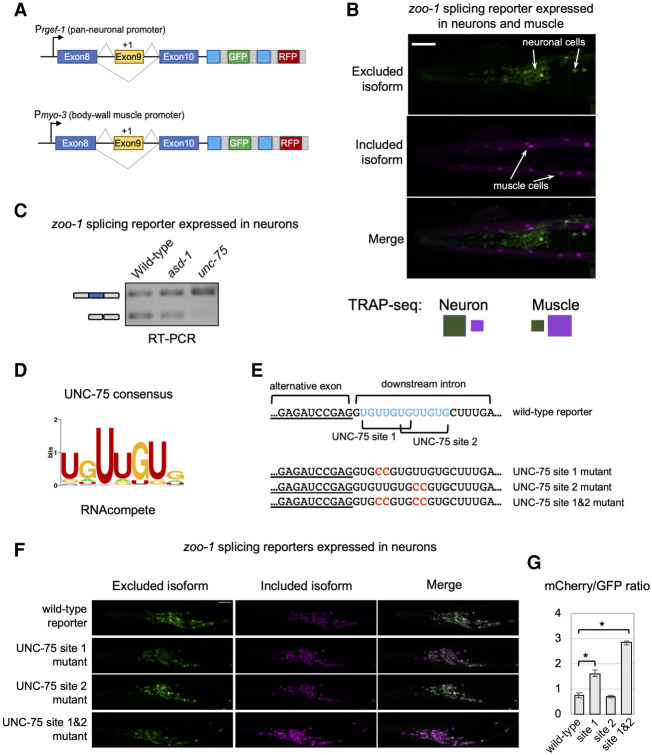
UNC-75/CELF represses inclusion of an exon by binding to cis elements overlapping a 5′ splice site. (A) Schematic of two-color reporters used for experiments. (Prgef-1) Promoter driving pan-neuronal expression; (Pmyo-3) promoter driving body-wall muscle expression. (B) Fluorescence microscopy images of zoo-1 two-color reporter monitoring splicing of exon 9 in both neurons and muscle cells. Neurons display increased exon skipping (green), whereas muscle cells primarily include the alternative exon (purple). Scale bar, 20 μm. (C) RT-PCR assay monitoring zoo-1 two-color splicing reporter expressed only in neurons in wild-type animals (lane 1), asd-1 mutants (lane 2), and unc-75 mutants (lane 3). Primers are designed to amplify both exon 9 included (top band) and excluded (bottom band) isoforms. (D, left) UNC-75 consensus motif derived from RNAcompete data (Ray et al. 2013). (E, top) Schematic of 3′ end of zoo-1 exon 9 (underlined) and flanking downstream intron sequence. Two UNC-75 consensus sequences overlapping the 5′ splice site are highlighted in blue. (Bottom) Reporters with mutated UNC-75 consensus sequences (substitutions in red). (F) Fluorescence microscopy images of wild-type and mutant two-color zoo-1 reporters as described in E. Scale bar, 20 μm. (G) Bar graph displaying mCherry/GFP fluorescence intensity ratios for each zoo-1 splicing reporter. Each bar represents mean ratio from five individual animals. Error bars, ± 1 SD from the mean value. (*) P-value < 0.01, Kruskal–Wallis rank sum test.